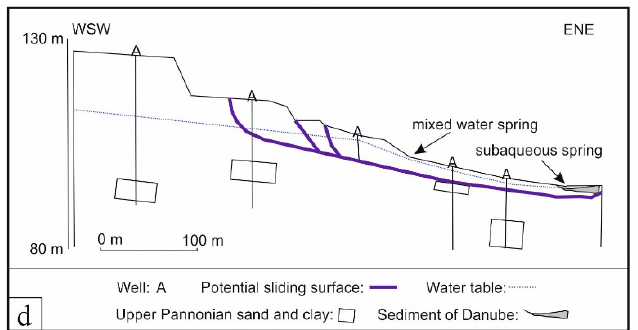
Figure 1. The study area in: ( a ) Europe; and ( b ) Hungary. The rose colored areas are the loess–paleosol sequences, the red lines show the mass movements areas and the circle indicates the location of the study area, Kulcs [21]; ( c ) map of Kulcs, where red areas show the four moving blocks, with a picture as an example of a local landslide (modified after [23]); and ( d ) schematic sequence of the study area with the potential sliding surface, water table, clayey layer, sediment of the river and spring [29].